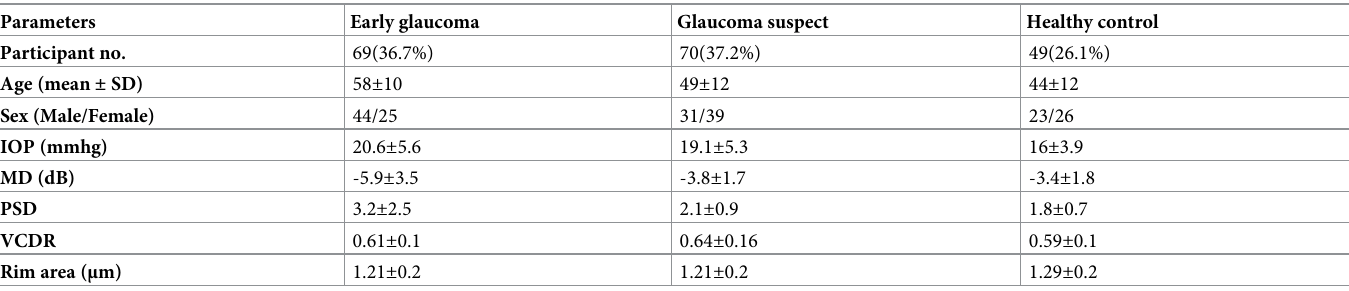
Table 1. Demographic characteristics of participants.